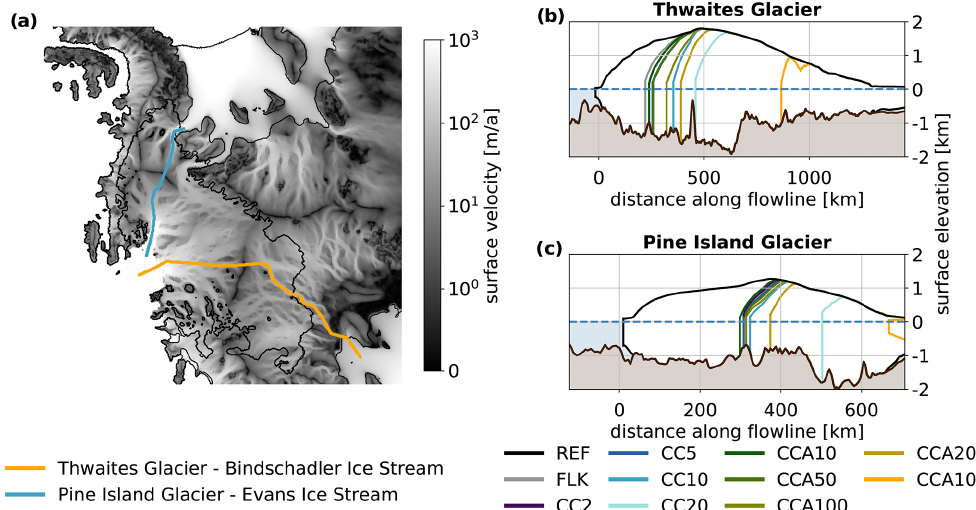
Figure 7. (a) Map of flowlines from Pine Island Glacier through Evans ice stream to the Ronne Ice Shelf and from Thwaites Glacier through the Bindschadler Ice Stream to the Ross Ice Shelf. (b, c) Bed topography and ice surface profiles after 60a runtime for Thwaites Glacier and Pine Island Glacier respectively. The distance along the flowline has its zero at the initial grounding-line position. Note that for Pine Island Glacier, the reference run also shows some grounding-line retreat.